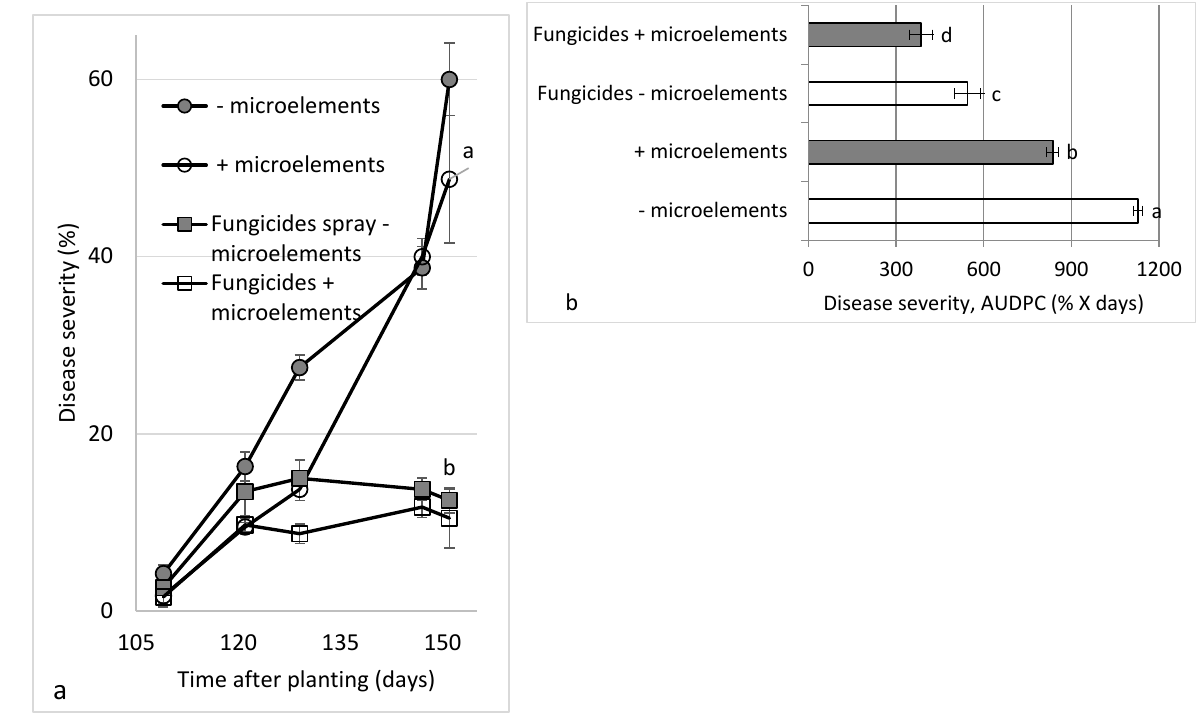
Figure 2. Effects of foliar applications of a microelement solution (Koratin: Fe-EDTA, Mn-EDTA, Zn-EDTA, Cu-EDTA and Mo mixture) and fungicides on sweet basil downy mildew (SBDM) severity in Experiment C1, Autumn 2015 – 2016. Treatments consisted of microelements (-/+ spray) coupled with fungicides treatments (-/+ spray). SBDM was evaluated ( a ) 109 to 151 days after planting and data are presented separately for ( b ) area under disease progress curve (AUDPC) through 42 days. Disease severity was evaluated on a 0 – 100% scale, in which 0 = healthy plants and 100% = plants completely covered by disease symptoms. Values in each graph and date followed by a different lower-case letter are significantly different according to one-way ANOVA with Tukey’s HSD test. Default significance levels were set at p ≤ 0.05. Bar = SE.